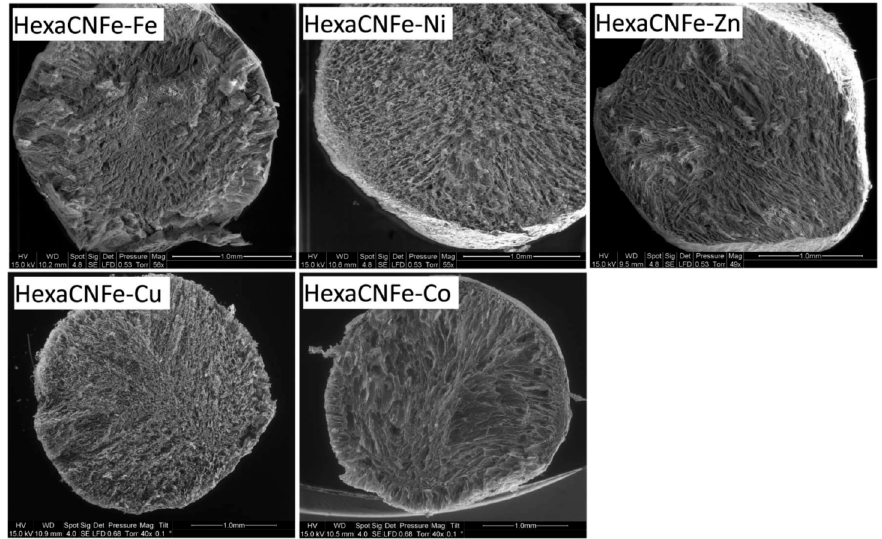
Figure 7. SEM analysis of cross-section of hybrid metal hexacyanoferrate/chitin beads (reprinted with permission from Royal Society of Chemistry [18]).